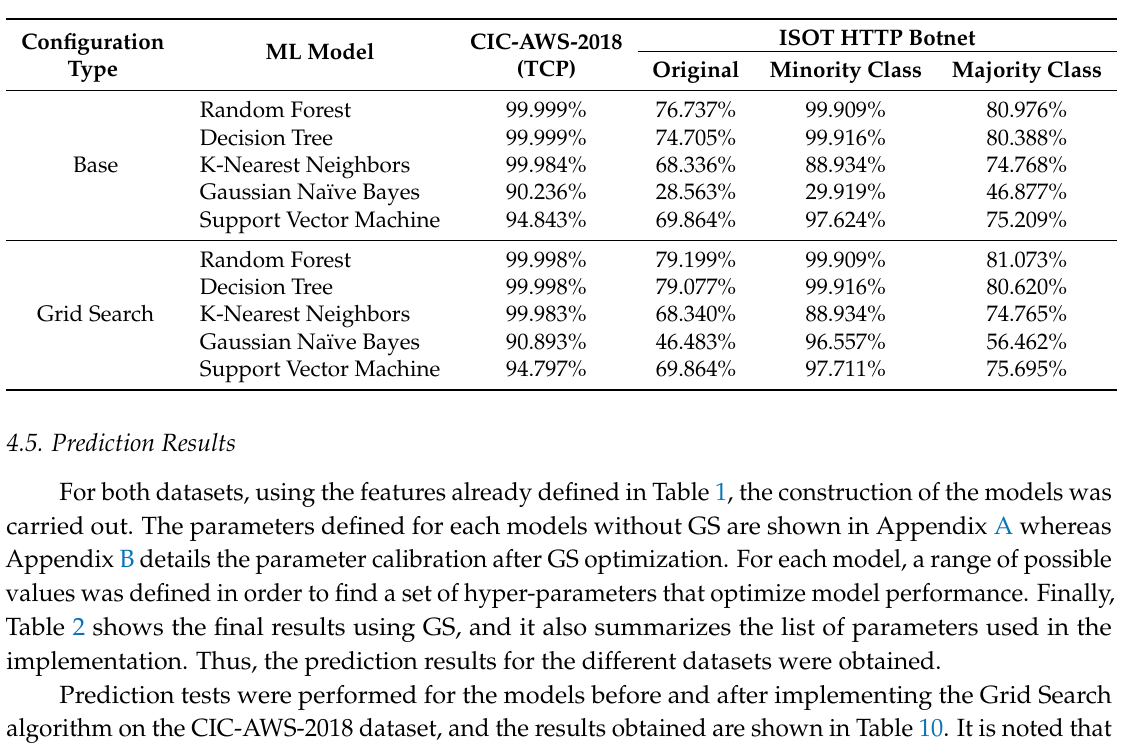
Table 9. Average accuracy of the different models in both